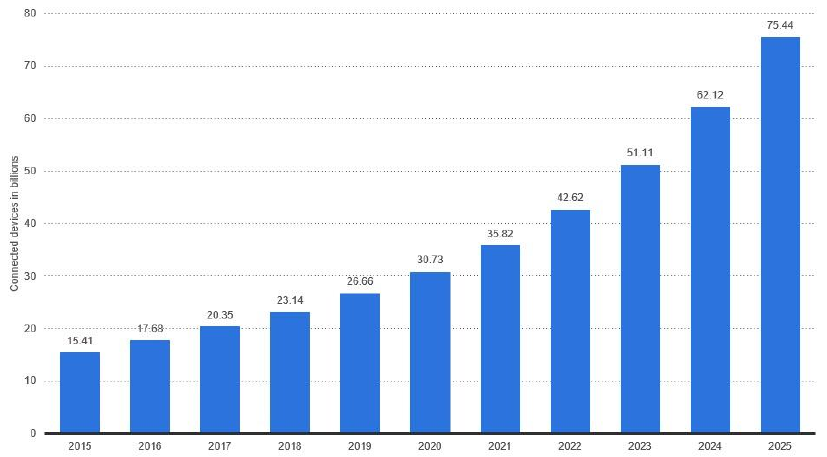
Figure 1. Internet-Connected IoT Devices Growth